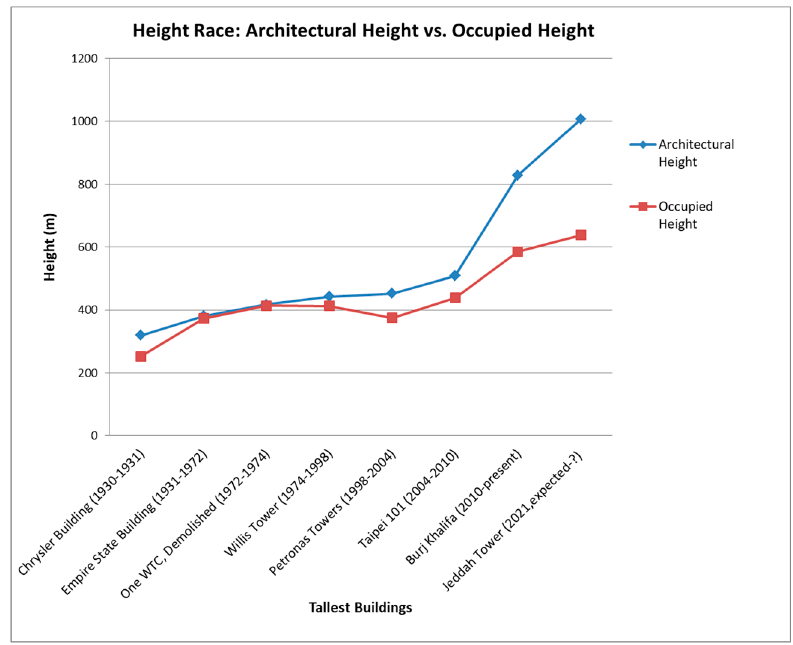
Figure 16. Height Race: Architectural Height vs. Occupied Height.